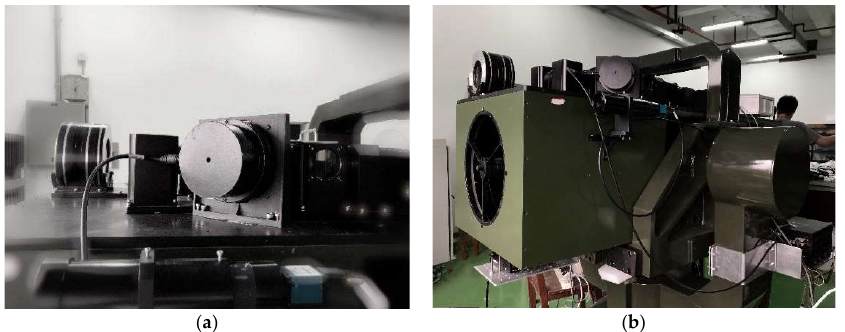
Figure 7. Photo of the experimental platform. ( a ) Photo of the transmitting FSM; ( b ) dual-FSM 3D GISC LiDAR tracking imaging system.